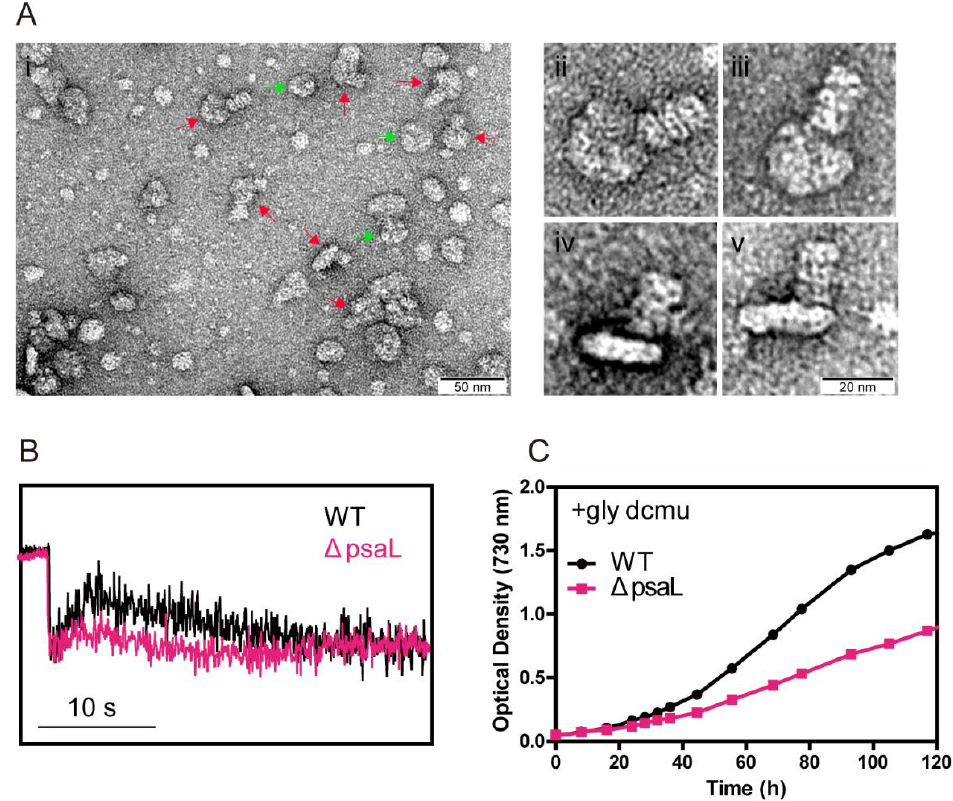
Figure 6. EM analysis of CpcL-PBS-photosystem I (PSI) complexes from Synechococcus 7002 and phenotypic characterization of ΔpsaL mutant. ( Ai ) Electron microscopic images of the negatively stained particles of the trimeric PSI (green arrows) and CpcL-PBS-PSI trimer complexes (red arrows). Bar indicates 50 nm. Panels ( Aii ) through ( Av ) show enlarged images of top view ( Aii , Aiii ) and side view ( Aiv , Av ) of individual complexes of CpcL-PBS-PSI trimer complexes. Bar indicates 20 nm. ( B ) PIRF analysis of the wild-type (WT) (black trace) and ∆ psaL (pink trace). ( C ) Photoheterotrophic growth of WT (black) and ΔpsaL ( pink ) in the presence of 10 mM glycerol and 10 μM DCMU under light intensity of 50 μmol photons m − 2 s − 2 .